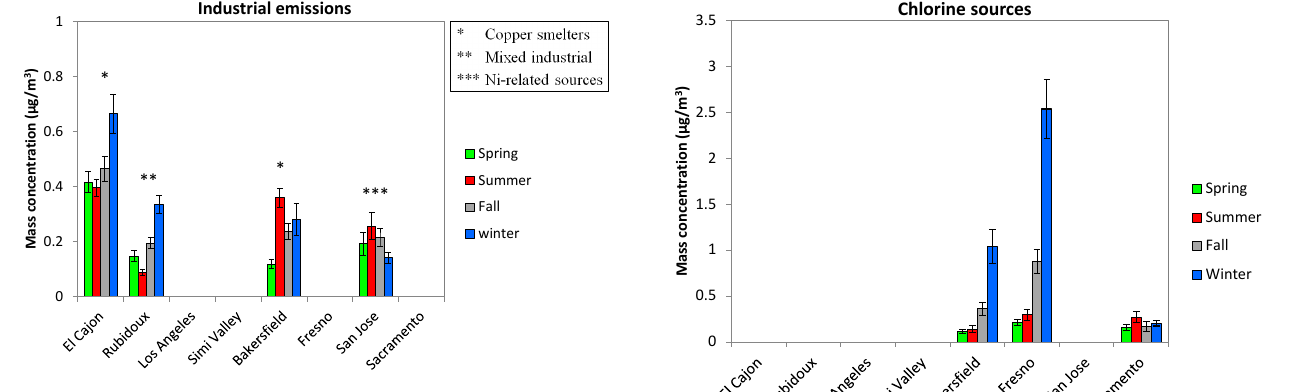
Figure 7. Seasonal average source contribution (µg/m 3 ) of industrial emissions to ambient PM 2.5 , by site. Error bars correspond to one standard error.